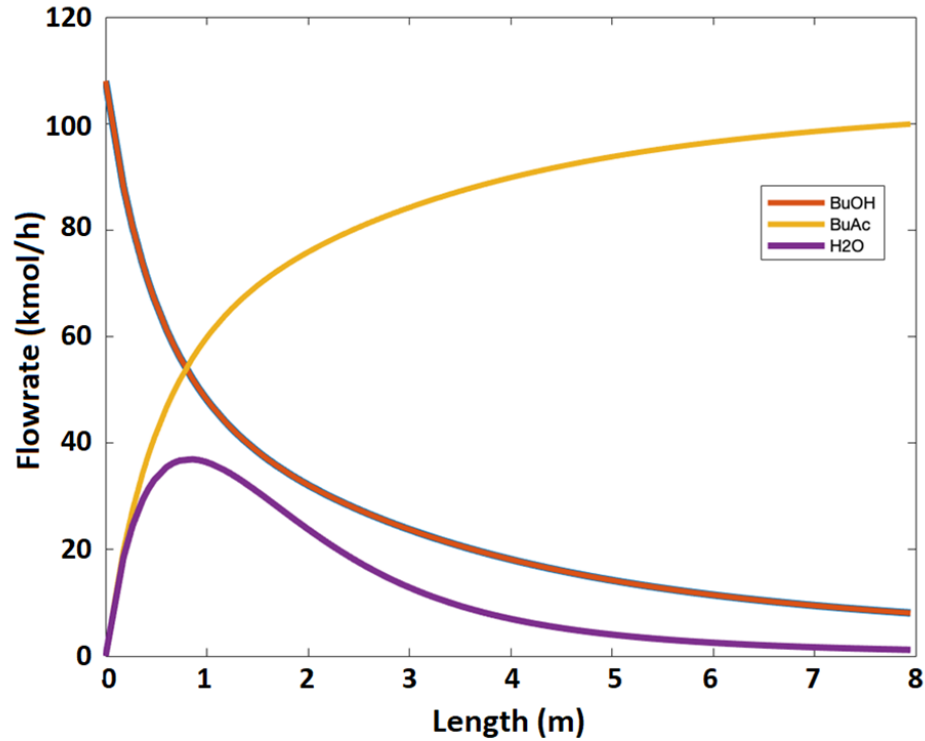
Figure 6. Components flow rates as a function of the length of the membrane reactor.